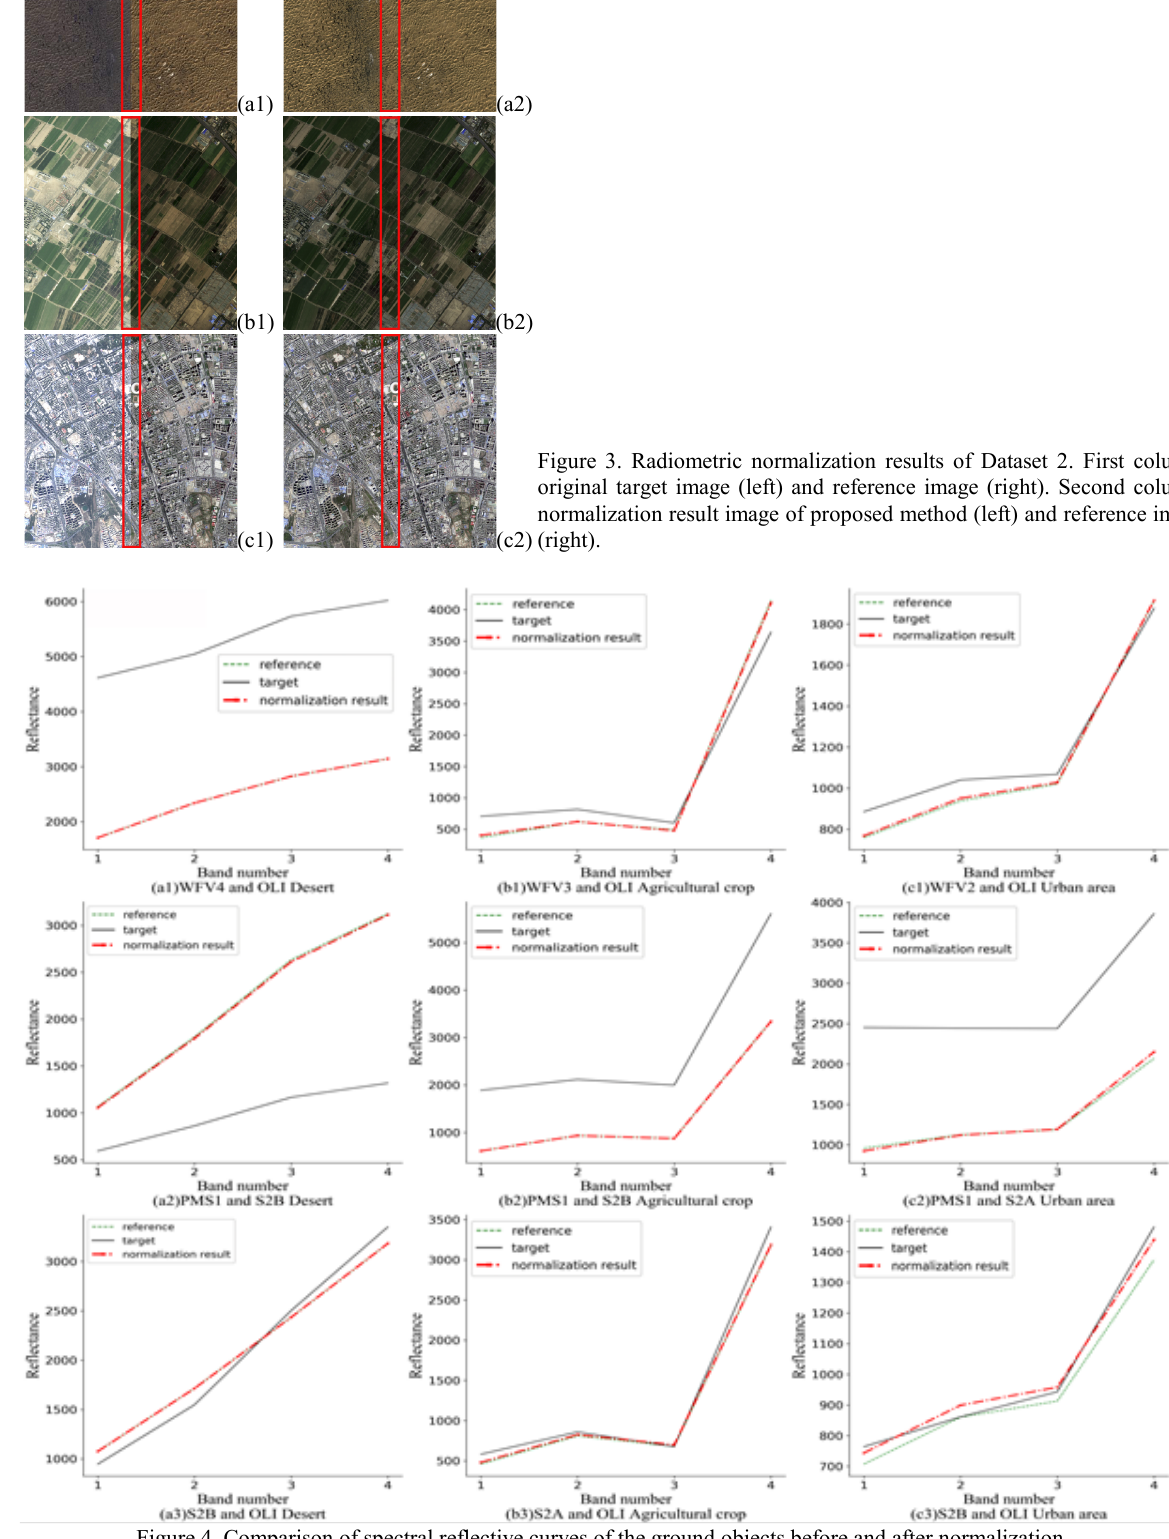
Figure 4. Comparison of spectral reflective curves of the ground objects before and after